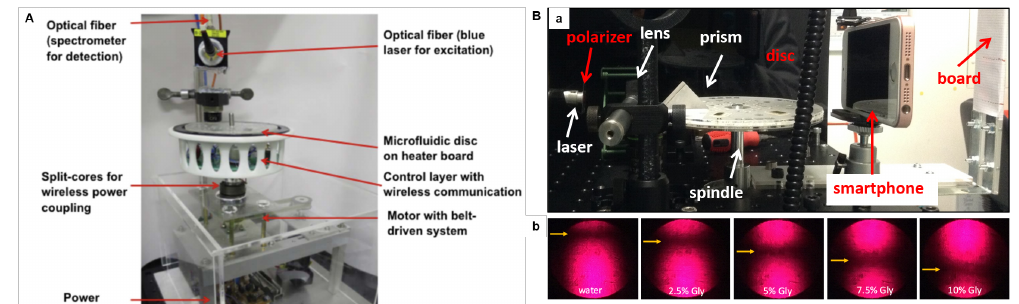
Figure 11. ( A ) LoaD set-up for LAMP assay-based bacterial infection sensor. A belt-driven motor to provide the centrifugal force; power coupling device; wireless data communication module for temperature control and signal detection; light source (blue laser at 488 nm) for the fluorescence excitation; and spectrometer linked to a data acquisition computer. The disc is on an electronic circuit board (PCB) accommodating the heating elements for microfluidic disc to the temperature control. Reproduced from [139] with permission from Elsevier. ( B ) SPR immunosensor set-up: photographs of ( a ) SPR optics integrated to a spin stand, and ( b ) the reflected laser spots from aqueous glycerol pattern solutions (with different refractive indexes) showing the position of the dark lines (caused by the plasmon absorption). Adapted from [87] with permission from